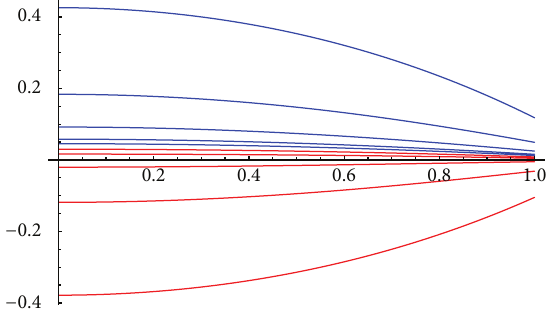
Figure 3: Plot of 𝑢 𝑛 (red) and V 𝑛 (blue), 𝑛 = 0,1, 2, 3, 4 for 𝜆 = 1 .